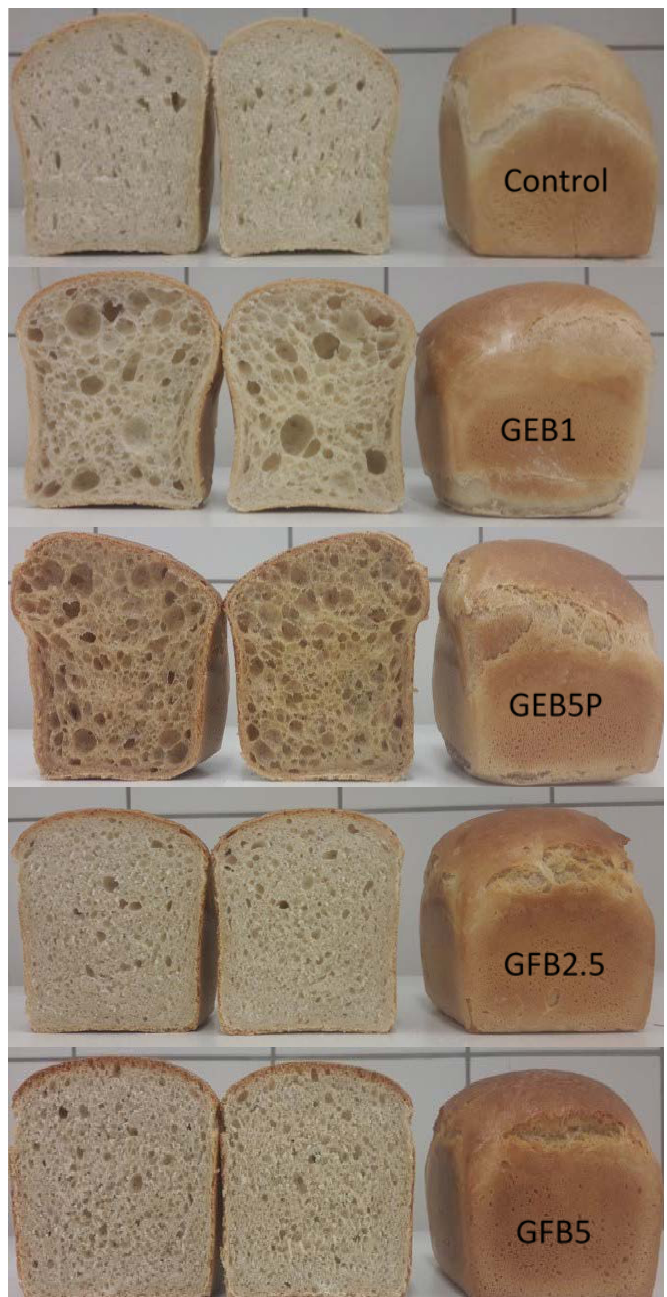
Figure 1. Photographs of bread prepared from white wheat flour (control), with 1% of »germinated + enzymatic treated« spelt flour (GEB1), with 5% of pasteurised »germinated + enzymatic treated« spelt flour (GEB5P), with 2.5% of “germinated + fermented” spelt flour (GFB2.5), or with 5% of “germinated + fermented” spelt flour (GFB5).